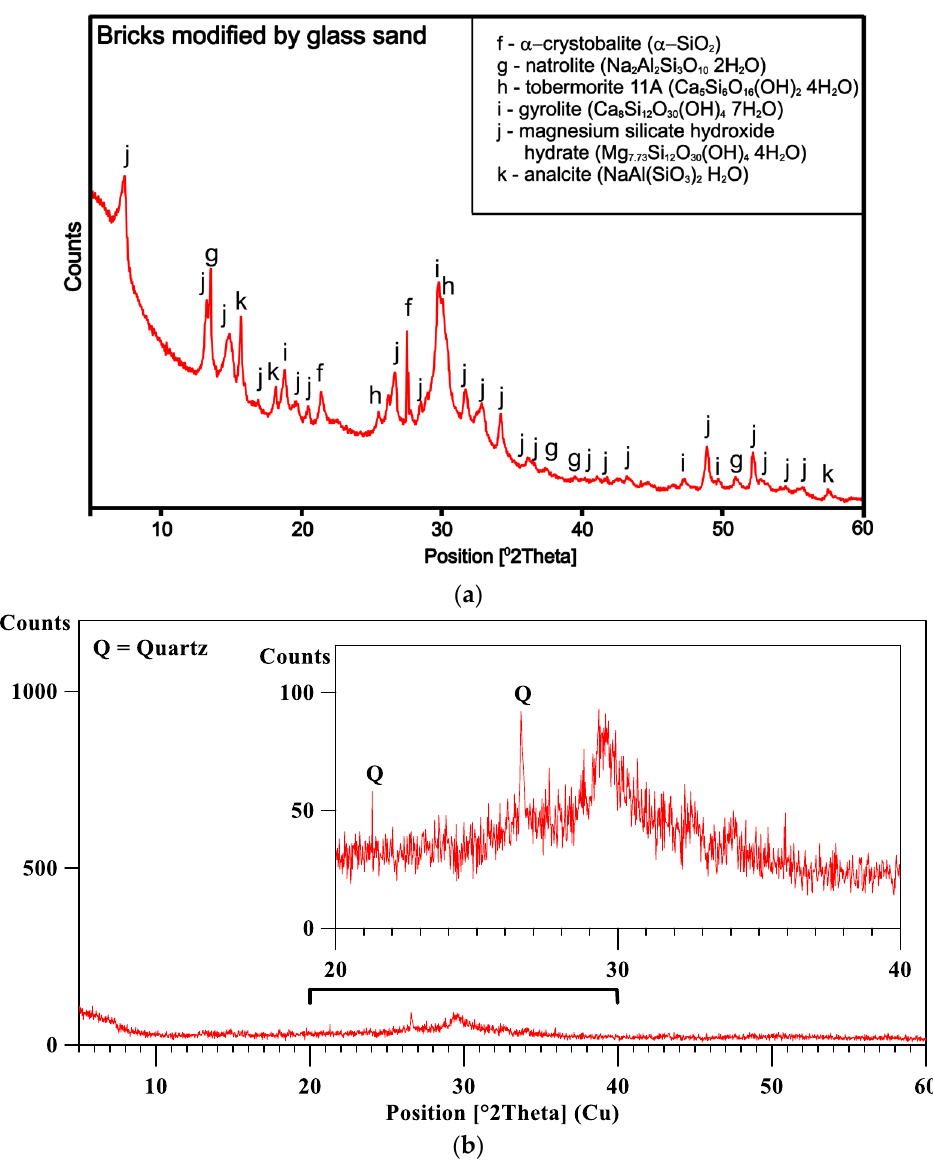
Figure 12. ( a ) X-ray diffraction (XRD) analysis of the bricks modified by 90% GS (after 2 months from initial production) [64]. ( b ) XRD pattern of the sample modified with 90% GS (after 26 months from initial production).